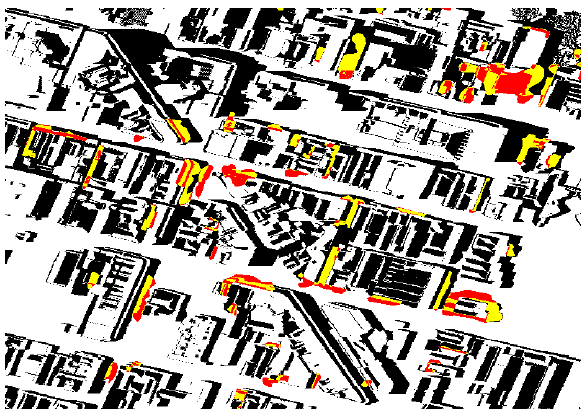
Figure 6 . Assessment of shadowing rate: shadow mask (black) overlayed with ground-level reference debris (red) in slant range geometry (yellow denotes overlapping